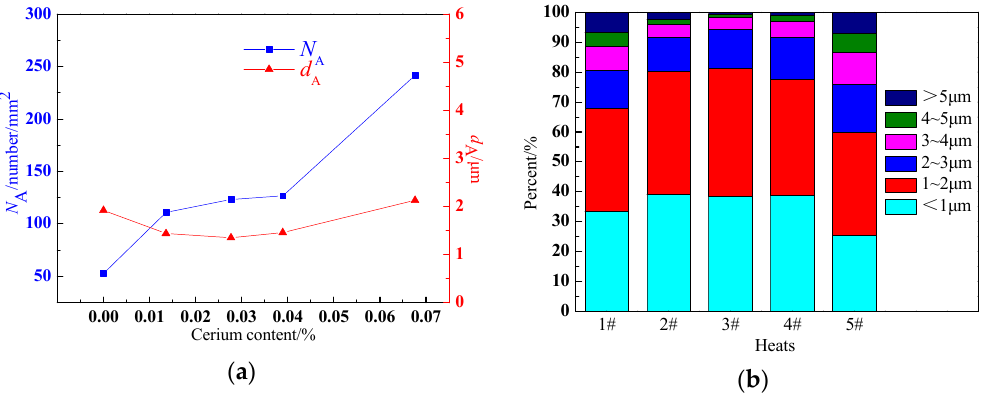
Figure 7. The effect of cerium content on the number of inclusions per unit area and the average diameters and distribution of the inclusion diameters in the 1 # ~5 # steel. ( a ) The number of the inclusions per unit area N A and the average size d A ; ( b ) distribution of inclusion diameters.